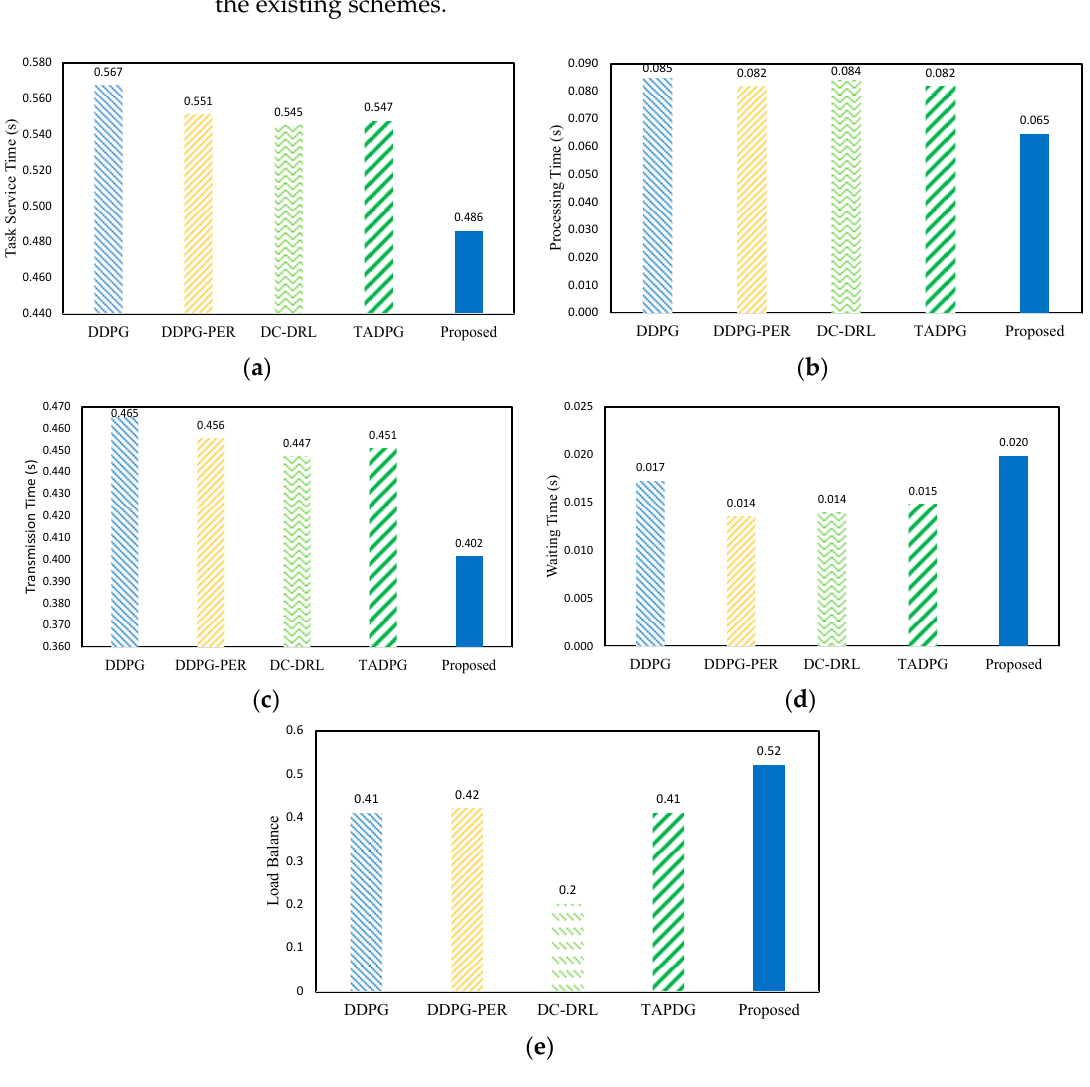
15 of 18 Figure 7. Normalized reward comparison with 10 and 20 edge servers. Table 3. Reward and variation comparison. Proposed-20